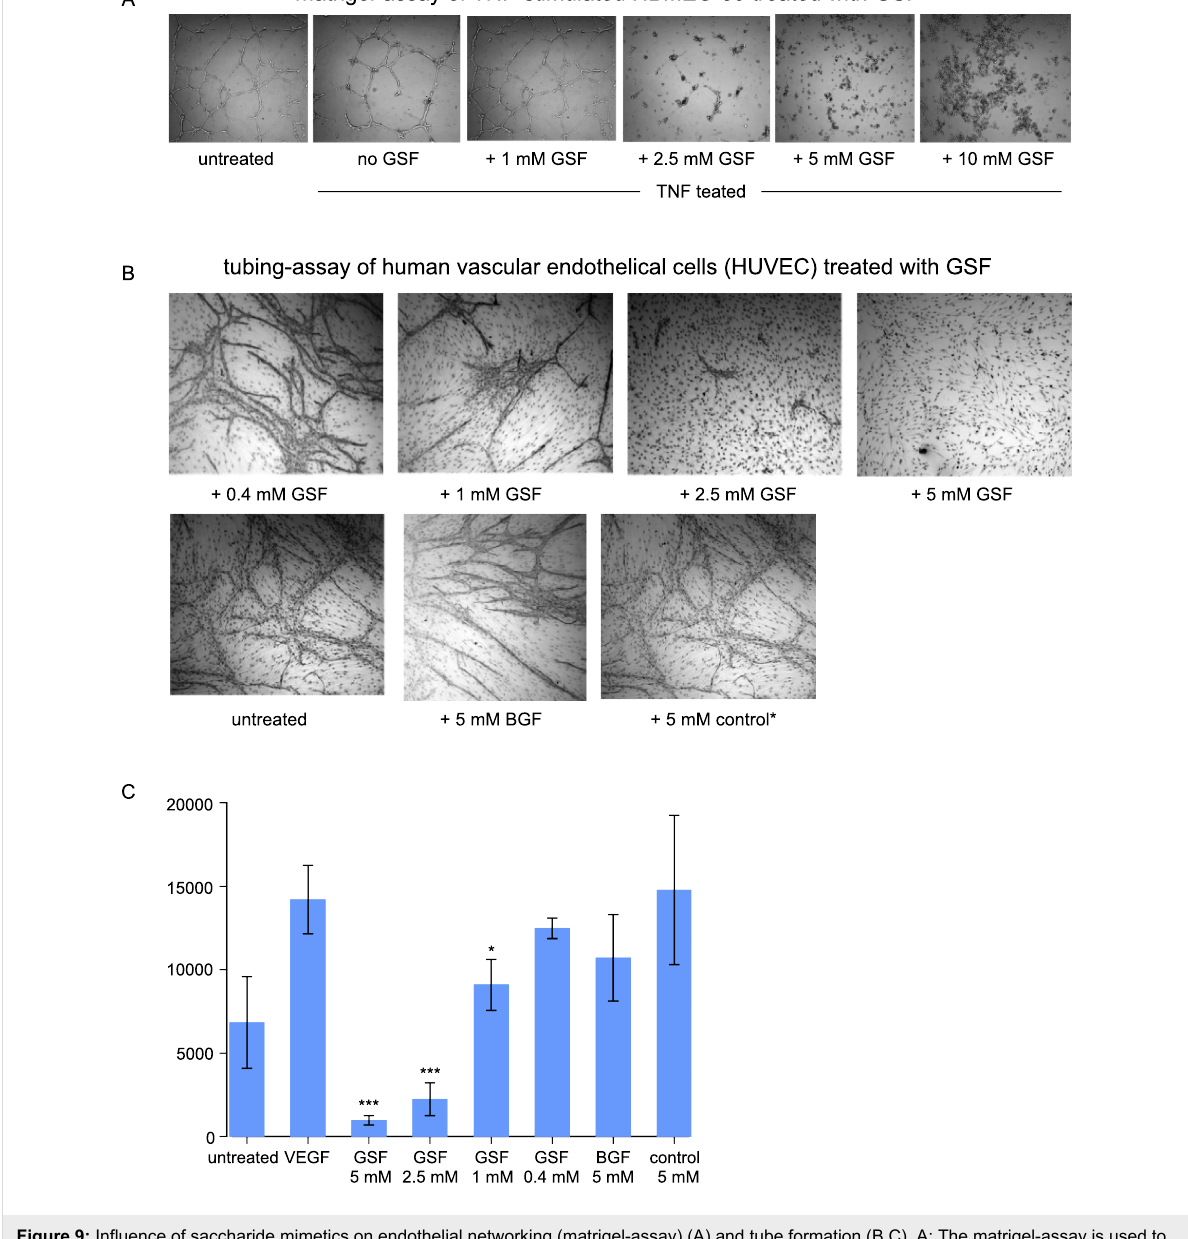
Figure 9: Influence of saccharide mimetics on endothelial networking (matrigel-assay) (A) and tube formation (B,C). A: The matrigel-assay is used to assess the initial stages of tube formation, i.e., the lining-up and subsequent formation of networks between endothelial cells. In the experiment shown, cells were stimulated with TNF or left untreated for 24 h, then (4-{[( β -D-galactopyranosyl)oxy]methyl}furan-3-yl)methyl hydrogen sulfate (GSF) was added in the concentrations indicated. The cells were then seeded onto the matrigel, which consists of a solubilized complex basement membrane of the EHS mouse tumor [44], and incubated overnight. B: The tubing assay measures the formation of endothelial tubules in a coculture of HUVEC and fibroblast cells (dots seen in the background). VEGF, which is necessary for proper in vitro tubule formation, was added at day 0 to the cells together with GSF or 3,4-bis{[( β -D-galactopyranosyl)oxy]methyl}furan (BGF) in the concentrations indicated. As one control, tubule formation is shown with VEGF only (untreated) or with 3,4-bis(hydroxymethyl)furan (5 mM control*). The growth media including growth factors and the respective mimetics were changed at days 4 and 7. At day 9 the medium was removed and the endothelial cells were stained with a monoclonal antibody against the cell surface antigen CD31 to allow evaluation of tubule formation. The assay was performed in three independent experiments with the same results in terms of the GSF effect. C: The tubule formation as observed under the microscopic was quantitatively analyzed using Angiosys 1.0 software, which counts the total tubule length, number of tubules and junctions between different tubules. Here, we show the results for total tubule length of an experiment performed as shown in panel B. The values are means and standard deviations of three experiments, * = p < 0.05, *** = p < 0.001 of the GSF exposed cells compared to VEGF alone. ANOVA one-way analysis of variance showed the concentration dependence of the GSF effect to be significant with p < 0.0001. The results for the other parameters reflected the same tendency of inhibitory capacity of GSF with increasing